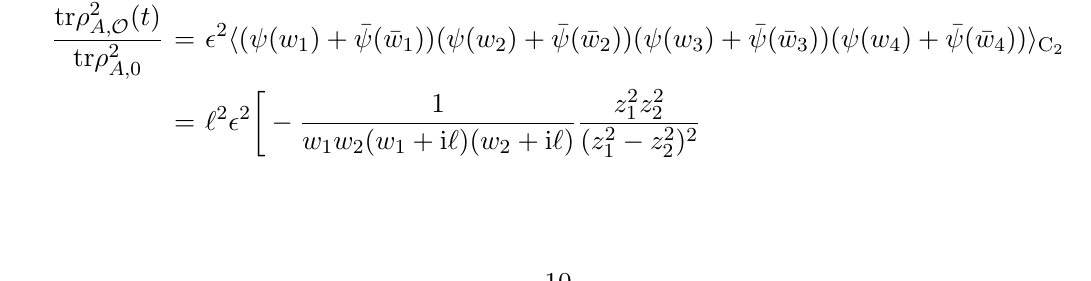
Figure 2 . The quantities of interest for this paper after a local operator quench with the insertion of a sum of holomorphic and anti-holomorphic primary (cid:12)elds with equal weight (i.e. q = 1 entanglement entropy (cid:1) S A ( t ) (2.37), the second R(cid:19)enyi entropy (cid:1) S (2) D A ( t; 0) (2.38), and the second Schatten distance D (2) and R(cid:19)enyi entropies coincide (this is an accident for q = 1 = 2) and also the trace distance and the second Schatten distance (this is instead always true). Right: trace distance D A ( t 1 ; t 2 ) (2.38) in the entire ( t 1 ; t 2 ) plane. For q = 1 = 2, the trace and Schatten distances can only be zero or 1 =